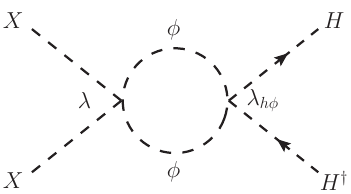
Figure 7: One loop correction contributing to the beta function of the λ